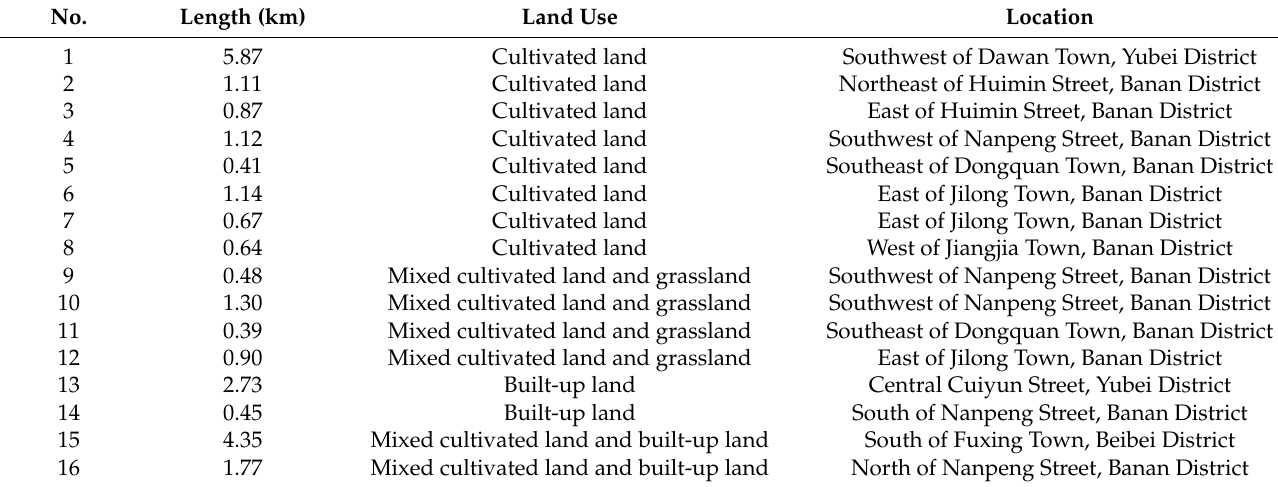
Table 11. The length and location of ecological barrier